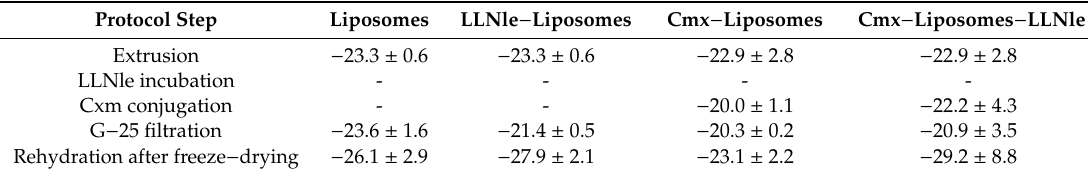
Table 2. ζ -potential (mV) of investigated liposomes monitored at di ff erent steps of protocol